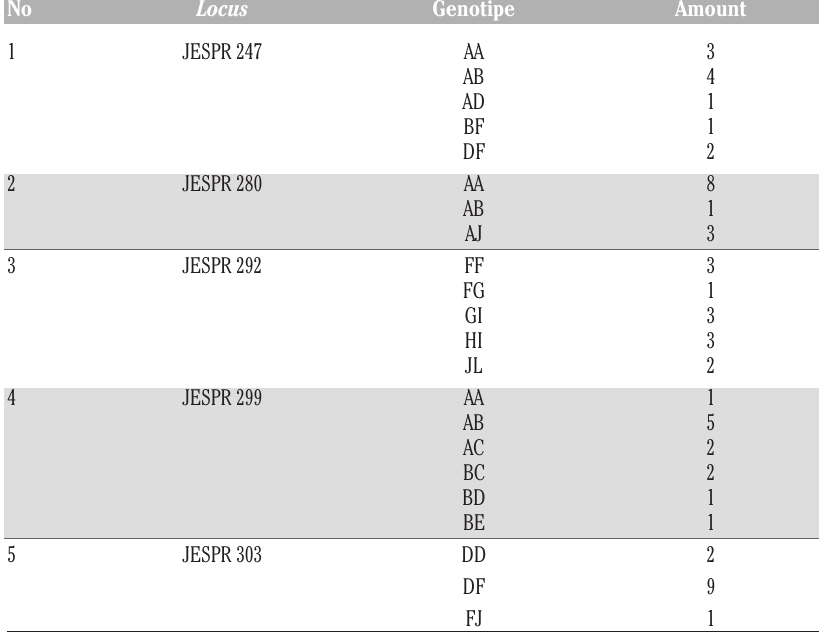
Table 3. The diversity of microsatellite DNA genotypes in 12 superior cotton